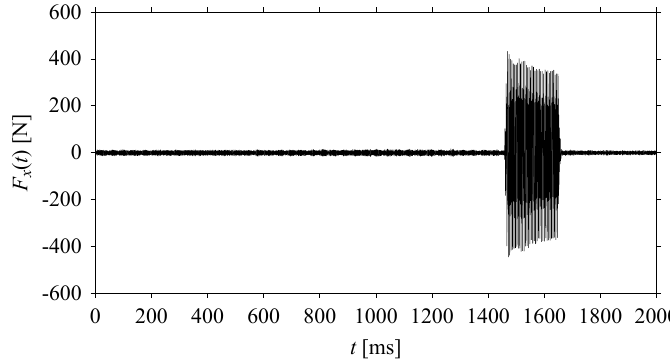
Figure 14. Time series of F x ( t ).